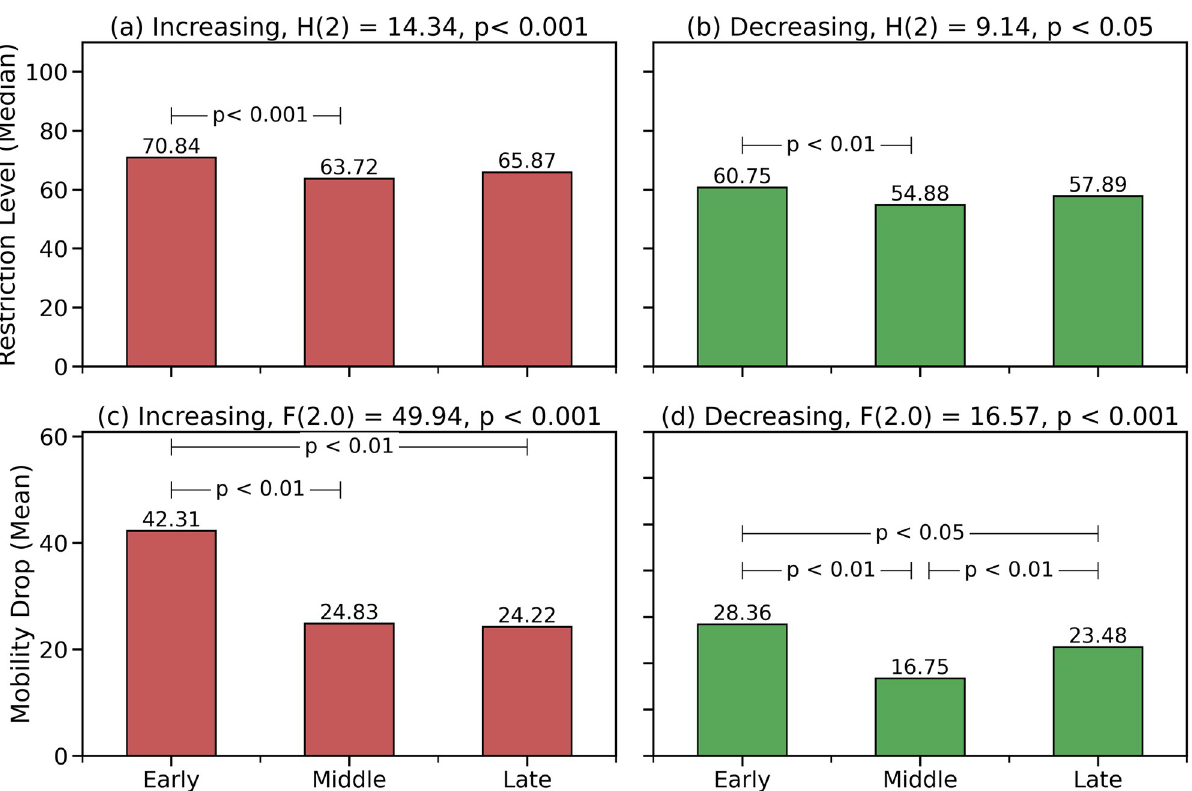
Fig 3. The results of a Kruskal Wallis test comparing restriction levels, during increasing and decreasing periods, by pandemic phase are shown as the title of each graph in (a) and (b): the H and p values are provided along with degrees of freedom for each H value in brackets as is the common practice. The p values for the subsequent post hoc Dunn’s test are shown in (a) and (b) as horizontal lines connecting the phases for which there is a significant difference in restriction level with the corresponding p value threshold shown. Similarly, the results of the one-way ANOVA and Tukey HSD tests are shown in (c) and (d) for mobility drops with the F and p values for the one-way ANOVA indicated in the titles of (c) and (d) and the subsequent Tukey HSD results for significant pairs shown in the corresponding bar